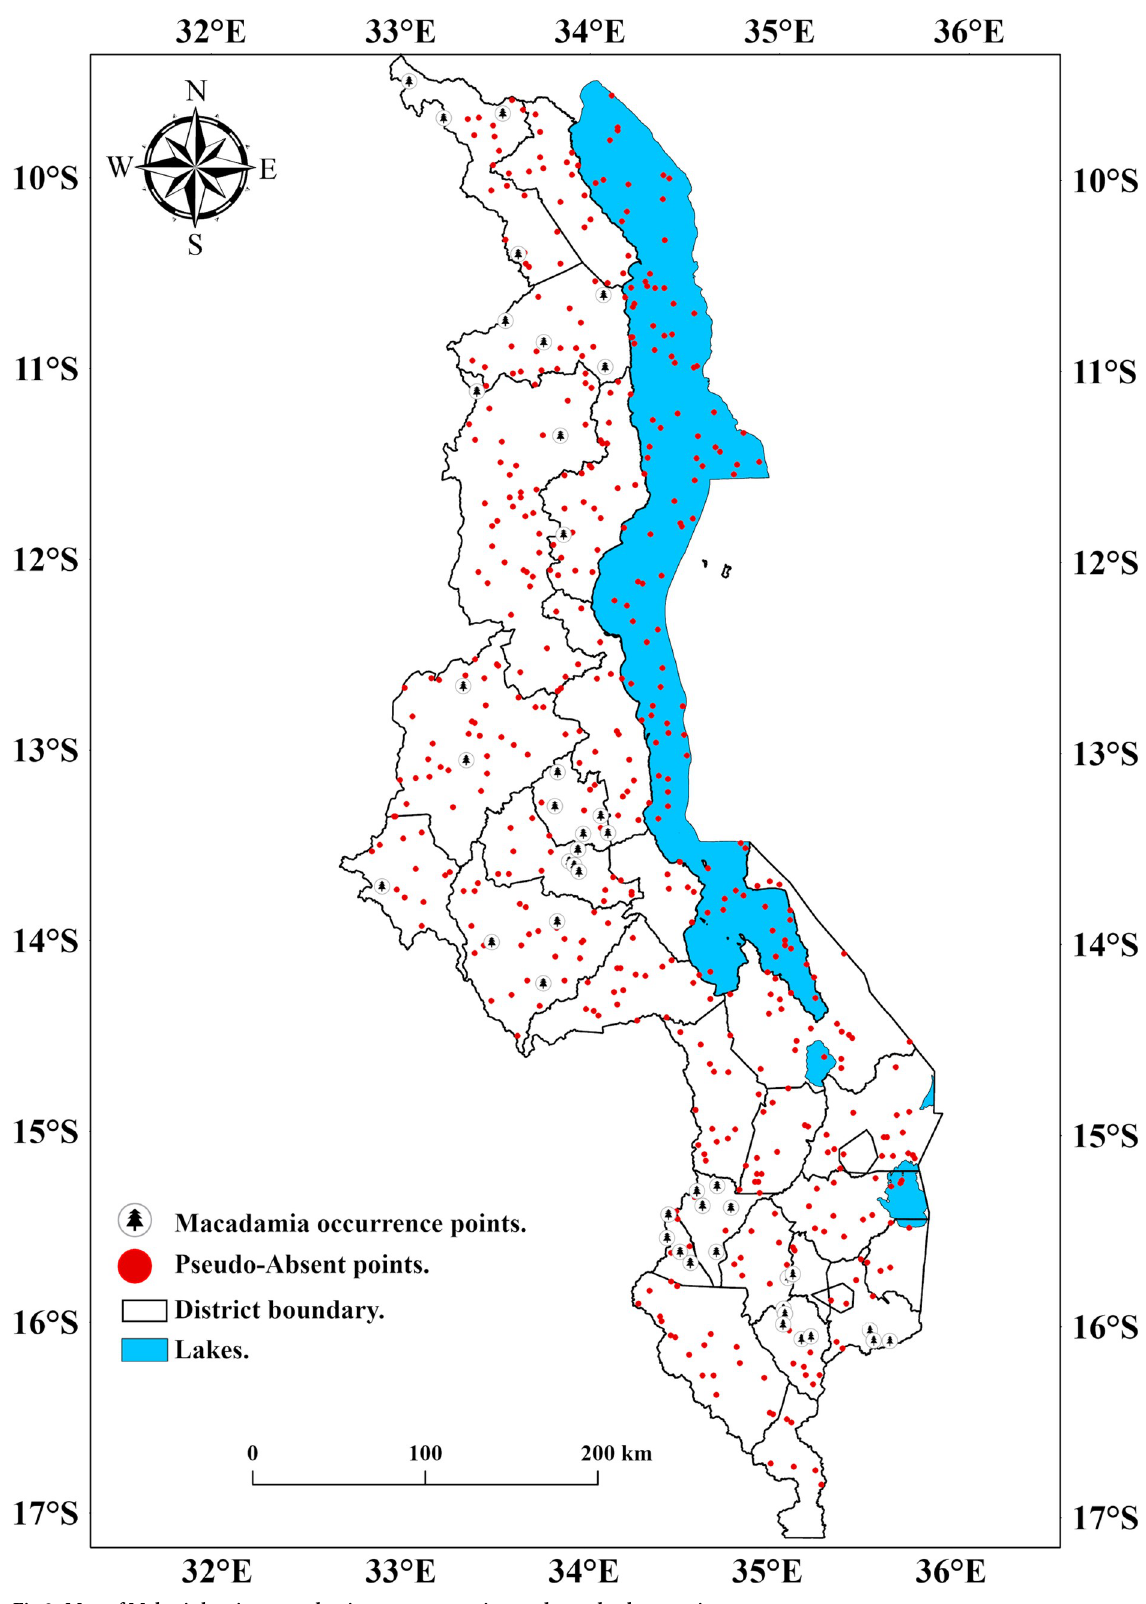
Fig 3. Map of Malawi showing macadamia occurrence points and pseudo absent points. https://doi.org/10.1371/journal.pone.0257007.g003 PLOS ONE | https://doi.org/10.1371/journal.pone.0257007 September 9,